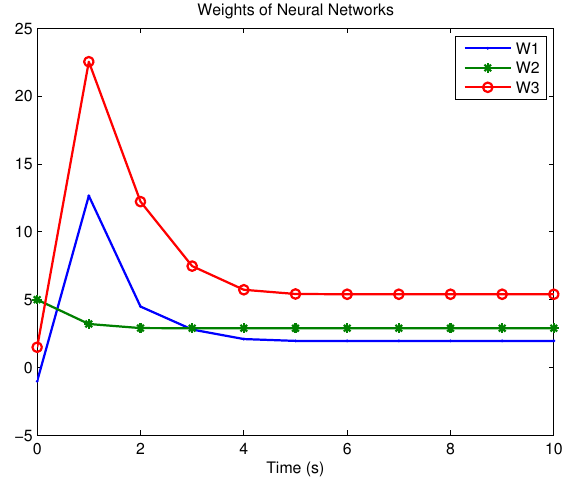
Figure 1. Neural network weight.